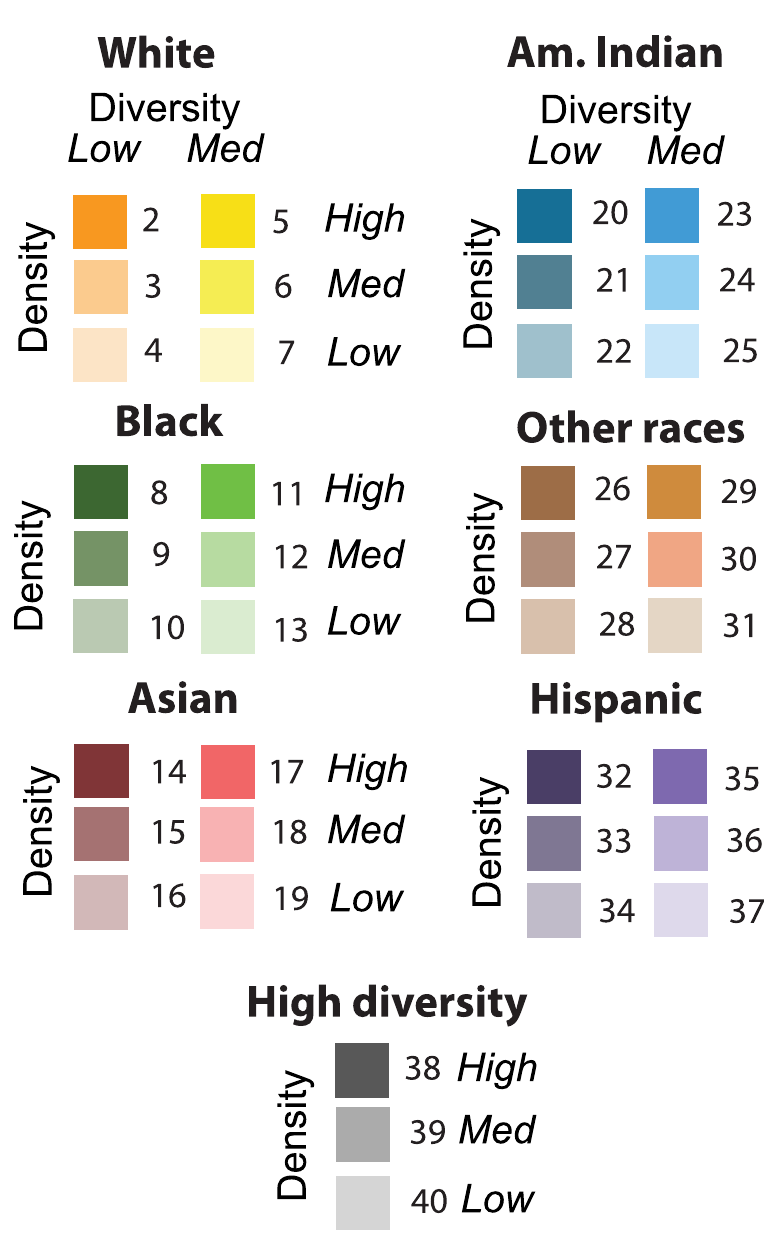
Fig 2. Classification of population into 39 different communities based on degree of diversity, dominant race, and population density. Colors serve as a legendto the diversity maps (see Fig 3), numbers are numerical labels as encodedin diversity data downloadable from